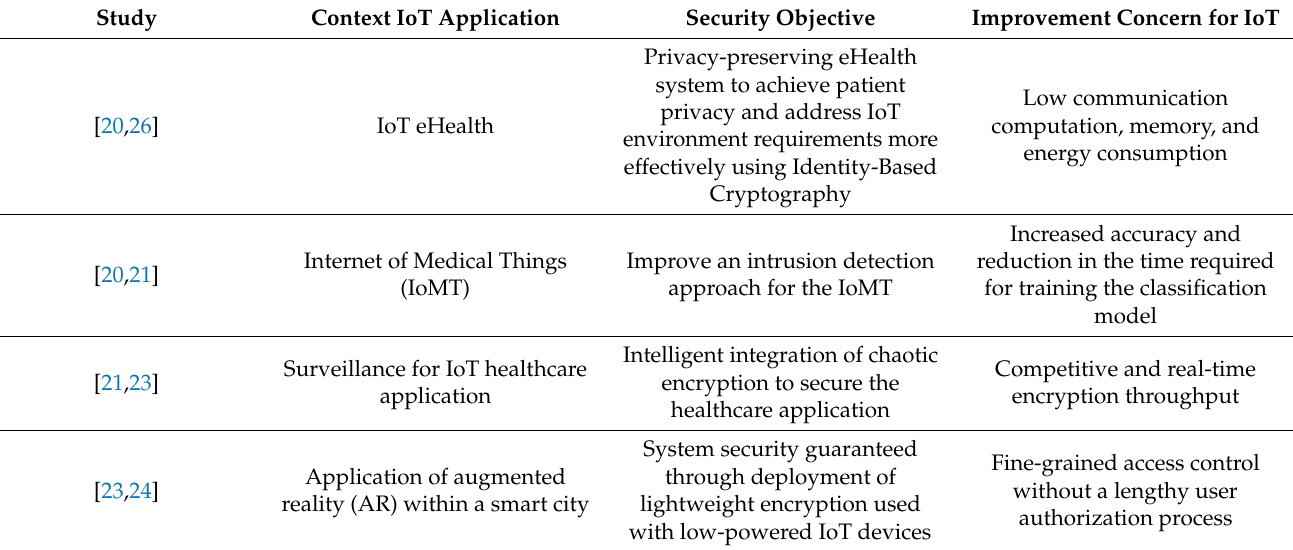
Table 1. Comparison between lightweight